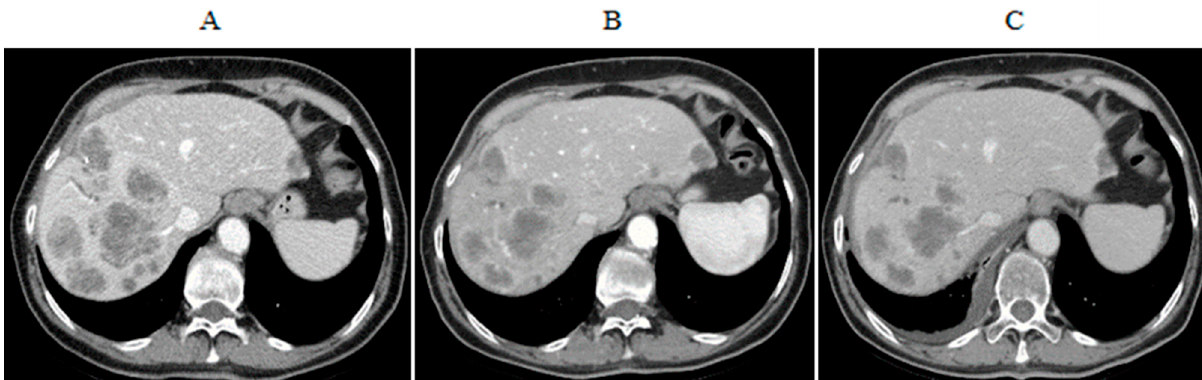
Figure 4. CT scans of the European Institute of Oncology (EIO) responding patient with liver metastasis from iCCA included in the phase II trial. She received two cycles of CS-PHP and achieved a partial response with reduction in the number and dimension of the lesions. Pictures show ( A ) pretreatment, ( B ) after first PHP and ( C ) after second PHP.